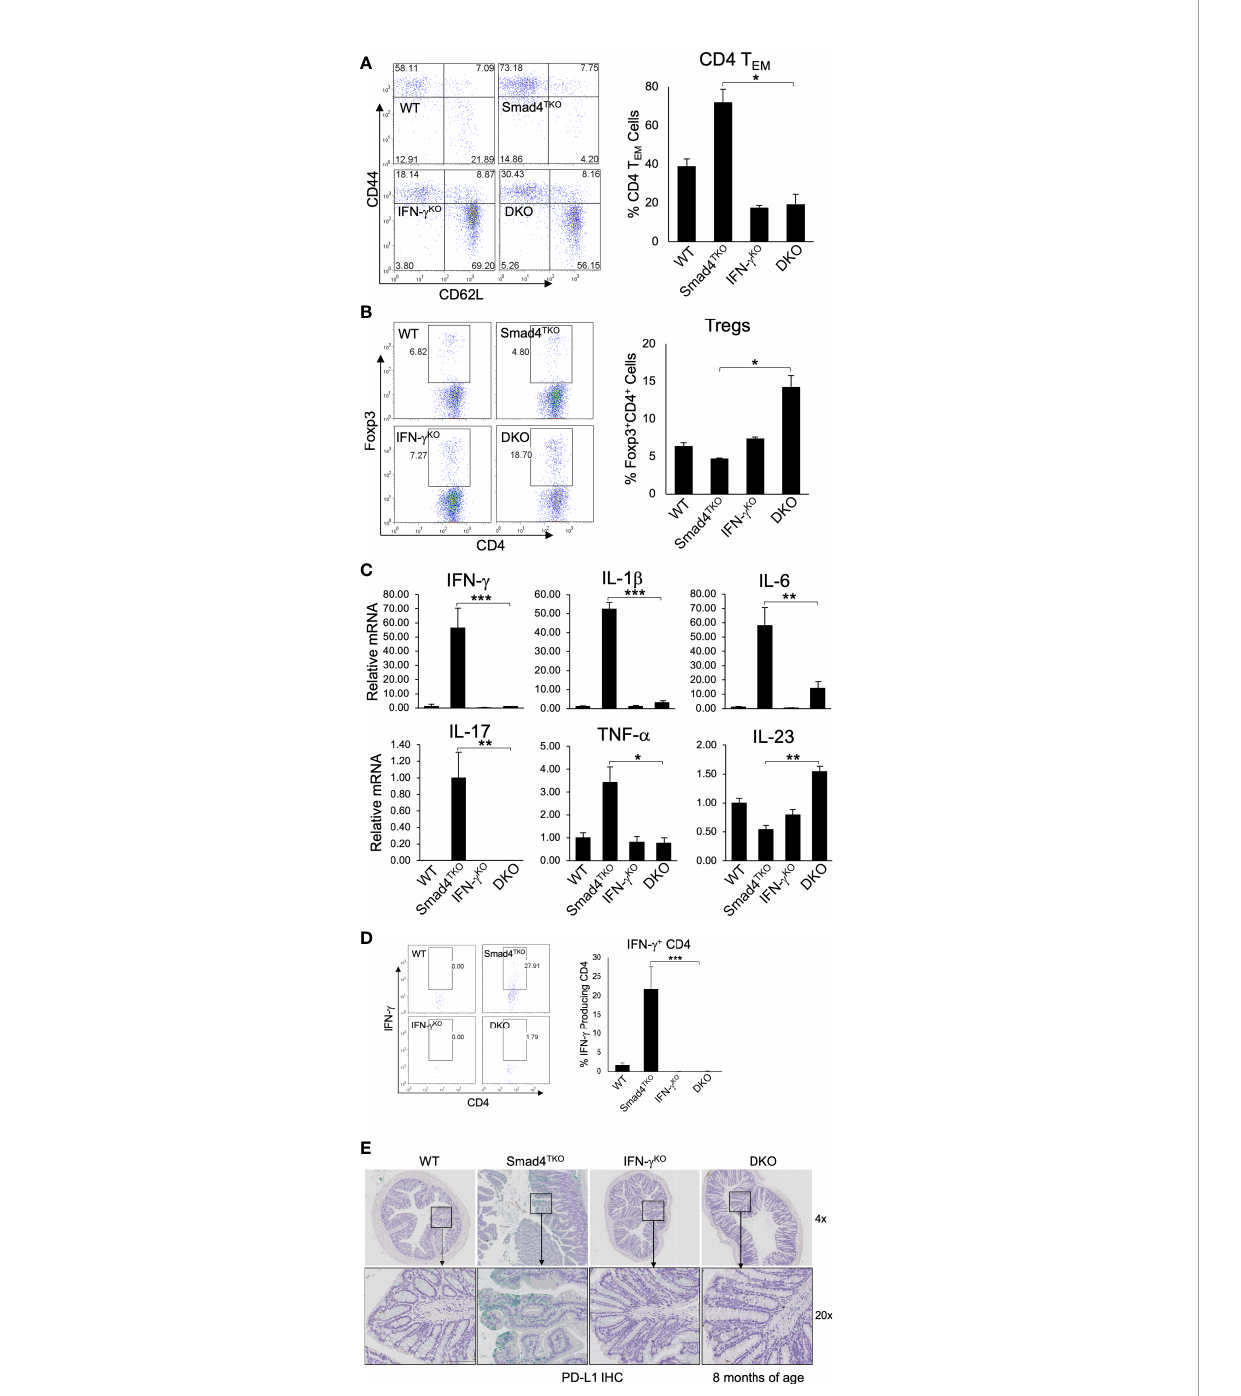
FIGURE 4 Deletion of IFN- g in Smad4 TKO mice decreases the population of effector memory CD4 + cells. (A) Analysis of effector memory markers in CD4 + T cell compartment in the spleen of each genotype. Spleen cells per each genotype at 8 months of age were collected, stained with antibodies for CD4 and CD8, and analyzed for effector memory markers (CD44 High and CD62L Low ) in CD4 + T cell compartment. The bar graphs show the proportion of CD4 T EM cells from the fl ow cytometry analysis in the left (n=5). (B) Natural regulatory T cells in each genotype (n=3-5). (C) Relative mRNA expressions of pro-in fl ammatory cytokines including IFN- g IL-1 b , IL-6, IL-17, TNF- a and IL-23 in colon of WT, Smad4 TKO , IFN- g KO and DKO at 6 months (n=5-7). (D) Analysis of effector CD4 + T cells expressing IFN- g in the colon of each genotype. Colon lamina propria per genotype were collected, stained on cell surface with antibody for CD4 and intracellularly with IFN- g antibody, and analyzed on CD4 + T cells by FACS. (E) Immunohistochemistry (IHC) staining for PD-L1 in colons of each genotype. Error bars indicate S.E.; * p < 0.05, ** p < 0.01, *** p <